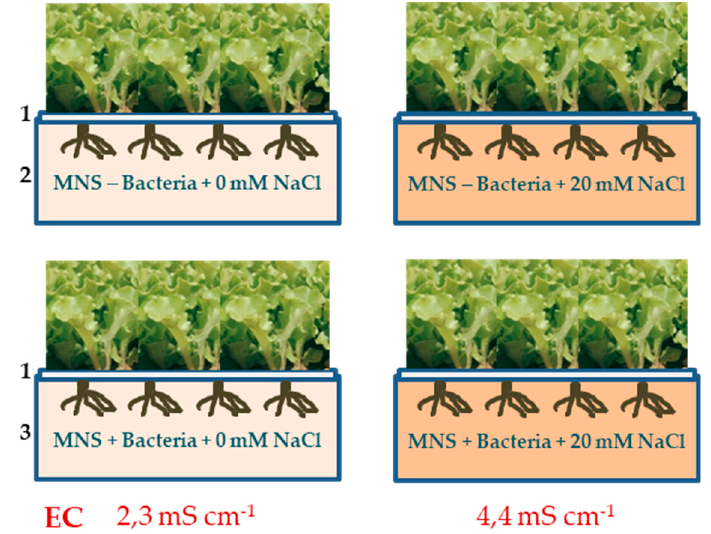
Figure 1. Graphical representation of the hydroponic floating system consisting of drilled polystyrene panels floating on mineral nutrient solutions, with different combinations of bacterial inoculant (Bacteria) and NaCl levels. (1) Drilled polystyrene panels (300 plants m − 2 ) floating on a mineral nutrient solution (MNS). Tanks containing 75 L of MNS added with two concentrations of NaCl and (2) not inoculated or (3) inoculated with the bacterial inoculant.